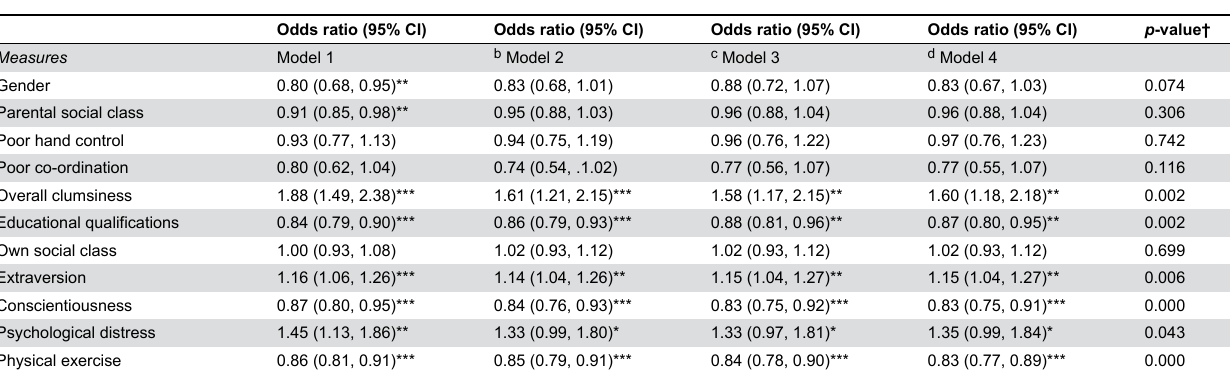
Table 3. Odds ratios (95% CI) for obesity at age 50, according to parental social class, childhood neurological function, educational qualifications, occupational levels, traits extraversion and conscientiousness, psychological distress, and physical